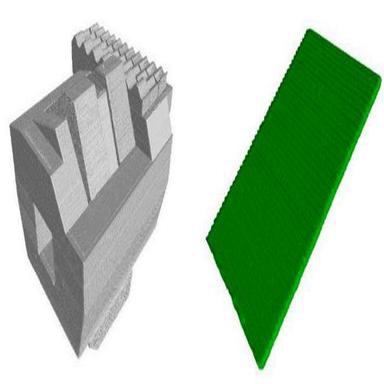
XCT volume reconstruction – 28 µm voxel size (left) and example of ramp extracted in.STL (right).